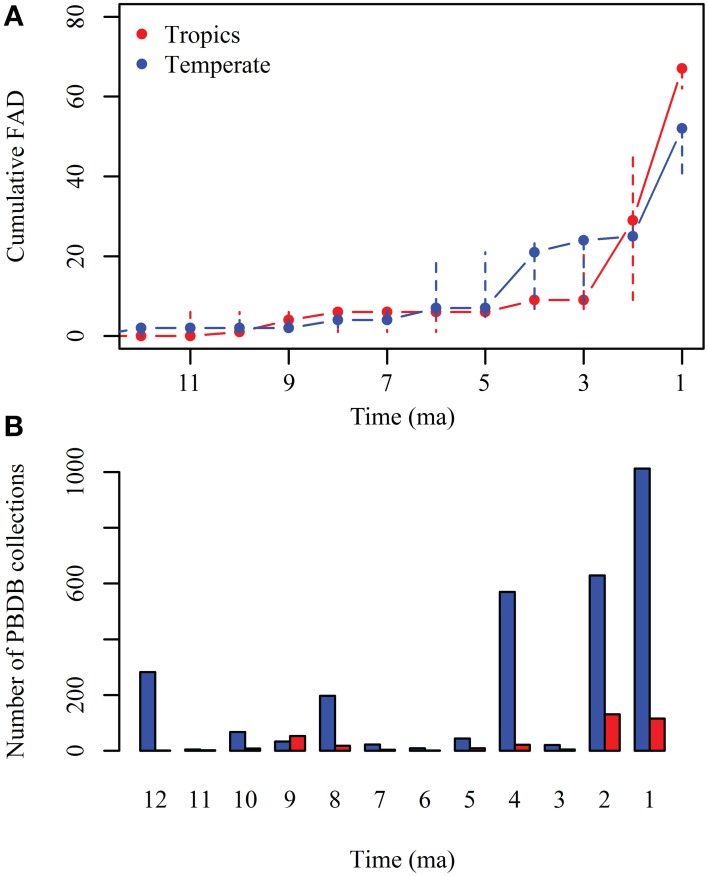
(A) Cumulative first appearance datum (FAD) of GABI participants in North and South America for each million year since 12 Ma; red, FADs record in the tropics; blue, FADs record in the temperate regions. Solid circles represent the mean and dashed lines the standard deviation. (B) Number of collections with records of land mammals in the Paleobiology Database (PBDB) for each million year since 12 Ma; red, collections in the tropics; blue= collections in the temperate region.